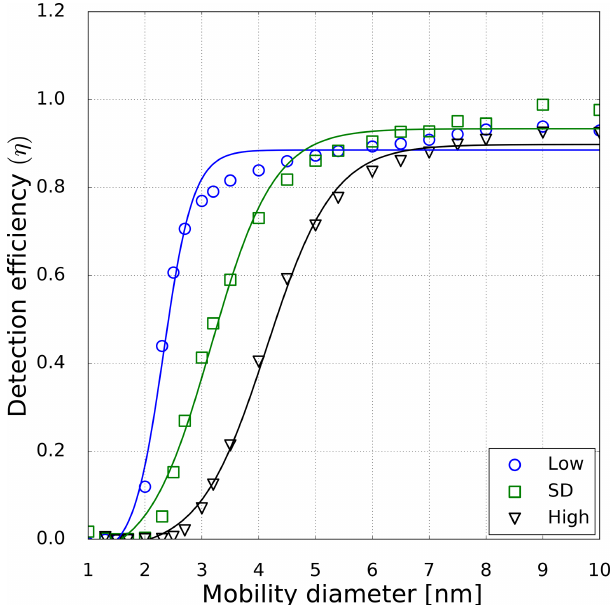
Figure 5. Detection efficiency as a function of mobility diameter for neutral sodium chloride particles. The symbols represent the measured counting efficiencies for low- (circles), standard- (std, squares) and high-temperature (triangles) settings at 10%RH at room temperature of the inlet line. The line displays a fit to the mea- sured counting efficiencies (Wiedensohler et al., 1997). Thereby the corresponding cutoff diameter with the detection efficiency of 0.5 can be